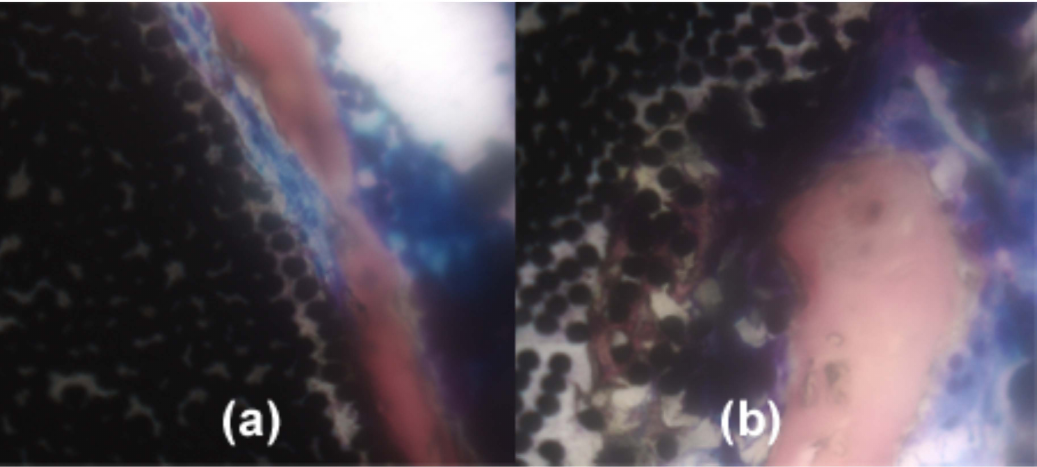
Figure 5. Horizontal histology section with Sanderson’s stain at 40X magnification. ( a ) Bone osseointegration at the implant surface can degrade the polymer matrix and pull carbon fibers outward; ( b ) Bone has osseointegrated at an implant surface defect to degrade and replace polymer matrix with osteoid that has even surrounded individual carbon